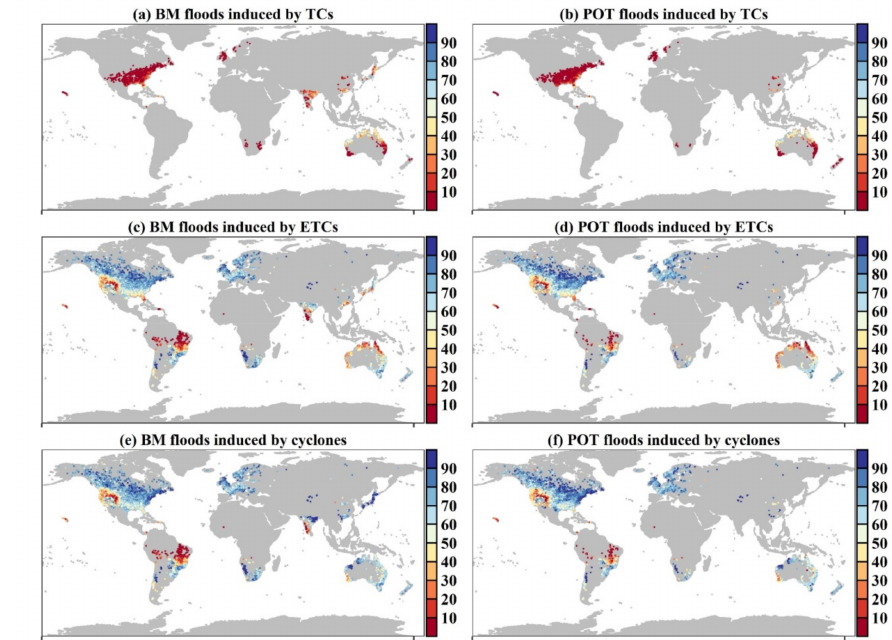
Figure 2. Contributions (%) of tropical cyclones (TCs), extratropical cyclones (ETCs), and all cyclones to annual floods in observations sampled by block maximum (BM) ( a , c , e ) and peak-over-threshold (POT) ( b , d , f ) methods.